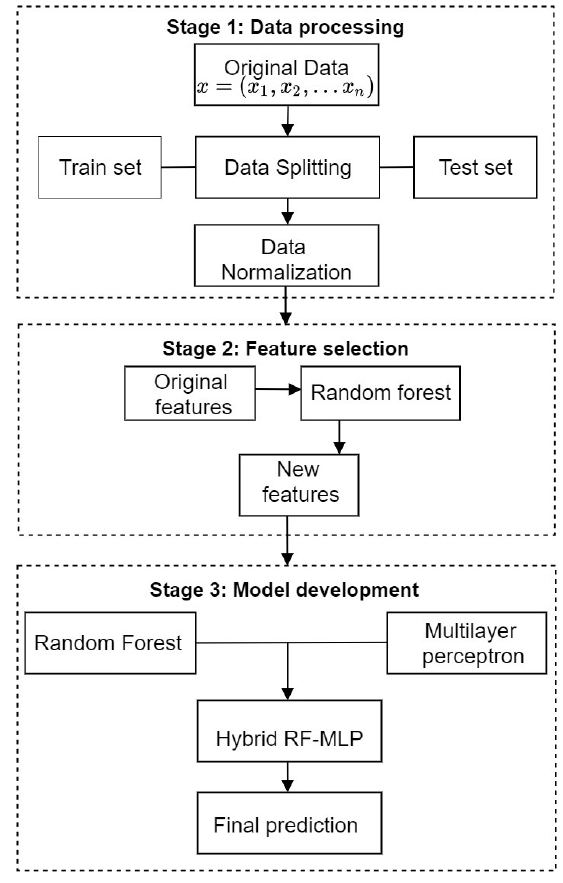
Figure 3. Schematic of the RF-MLP model. (Source: author).